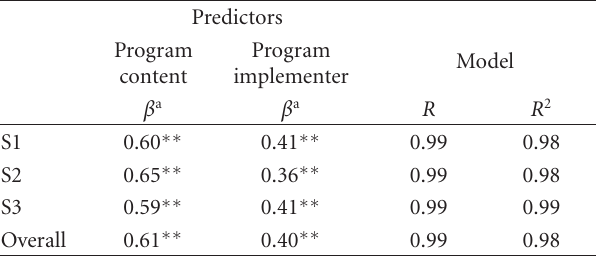
Table 8: Multiple regression analyses predicting program e ff ective-